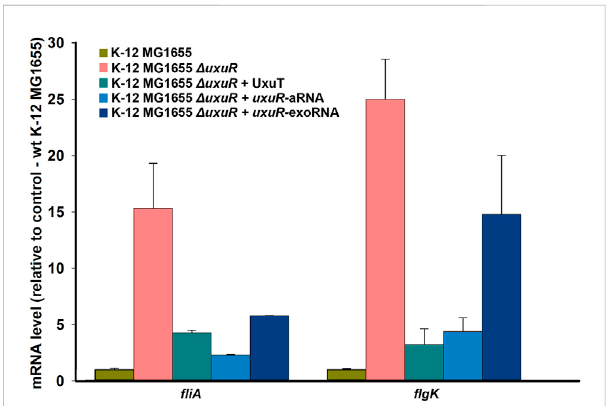
FIGURE 5 Correlation of the normalised read counts from the exoRNAs sequencing for the Escherichia coli K-12 MG1655 growing on D-glucose and D-galacturonate. Meanings deviated from